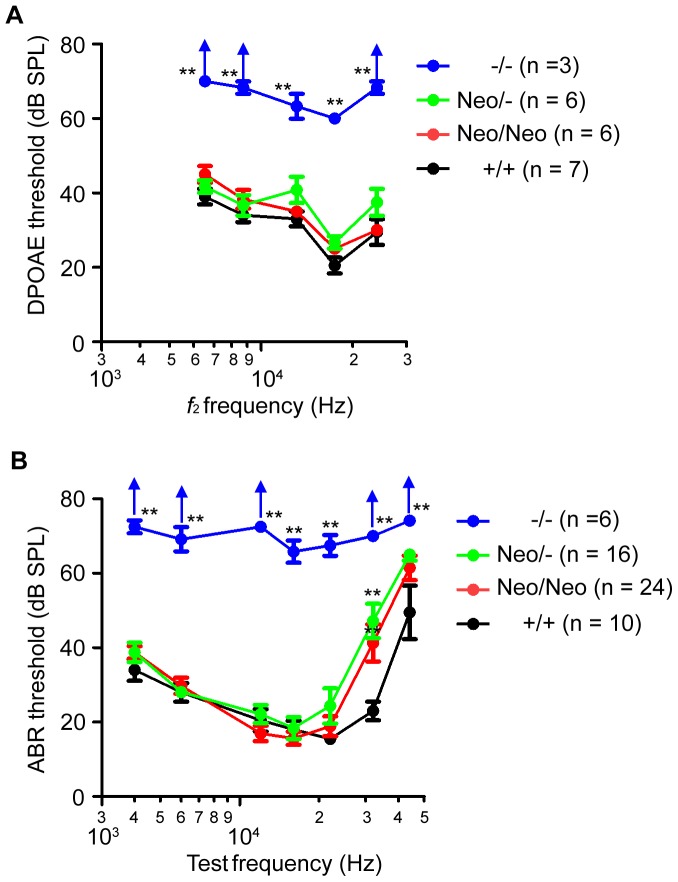
DPOAE (A) and ABR (B) thresholds of P21–24 mice of the indicated genotypes.Values are the mean ± SEM; **: P<0.01, *: P<0.05 by two-way ANOVA followed by Student's t test with a Bonferroni correction.